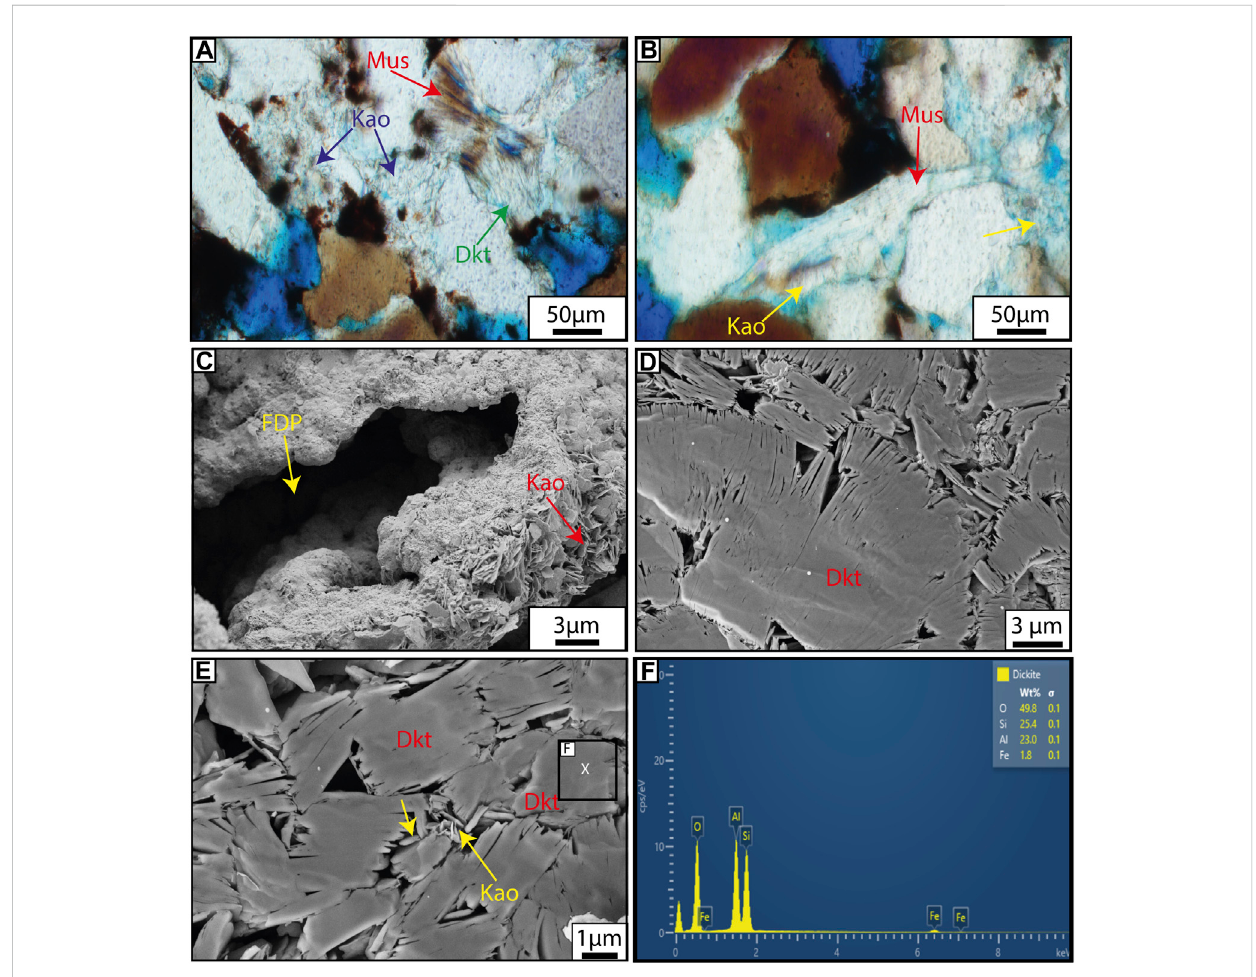
FIGURE 9 Thin-section photomicrographs and SEM images showing the mode of occurrence of kaolinite and dickite in the studied sandstones. (A) Kaolinite (Kao) growing around partly dissolved muscovite (Mus), and blocky dickite (Dkt) replaces the altered muscovite. (B) Authigenic kaolinite (Kao) replacing dissolved mica. (C) Kaolinite (Kao) occurring around feldspar-dissolution pore (FDP). (D) Blocky dickite (Dkt). (E) Blocky dickite (Dkt) and remnants of kaolinites (Kao). (F) Chemical composition of the dickite identi fi ed in (E)